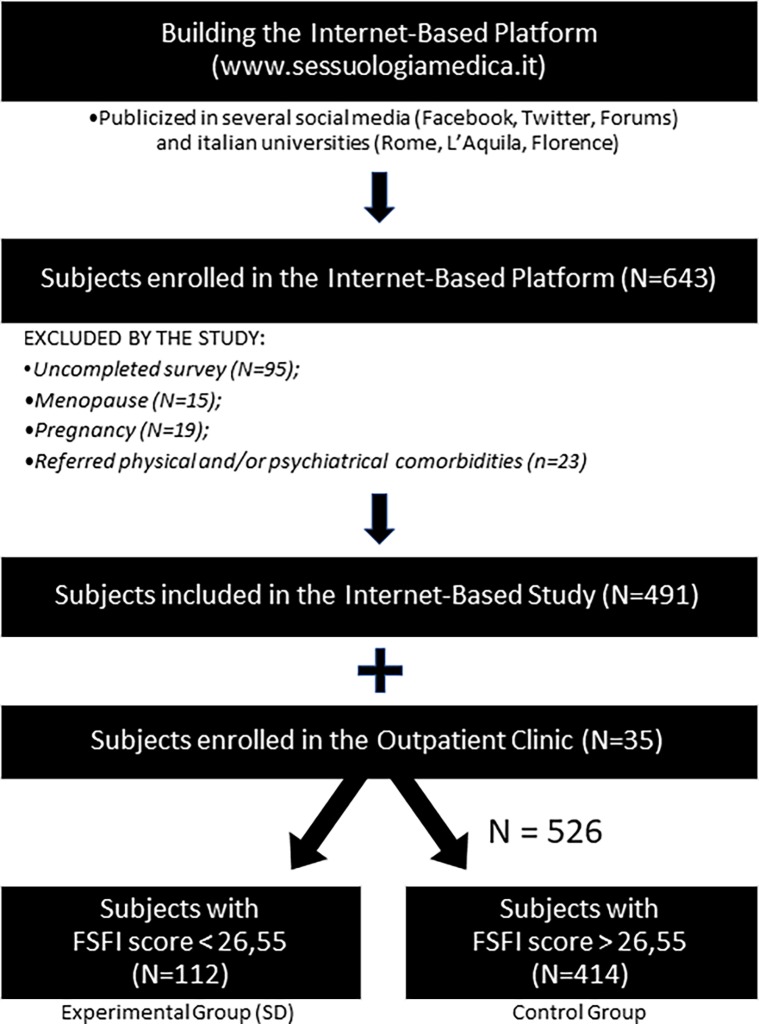
A flowchart showing the study design.